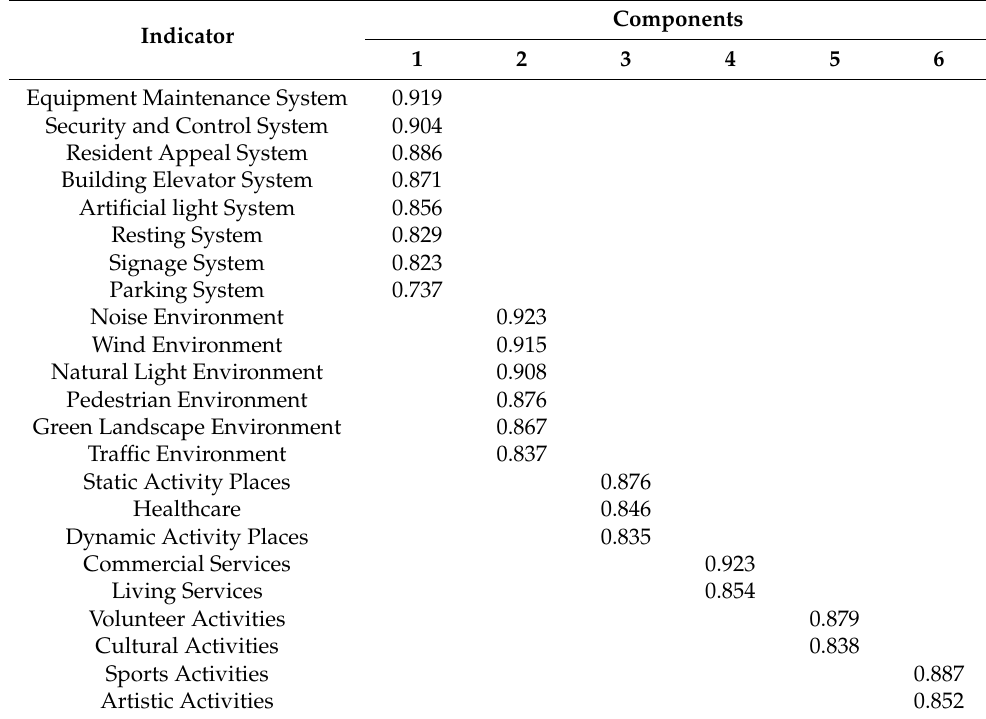
Table 1. Rotational component